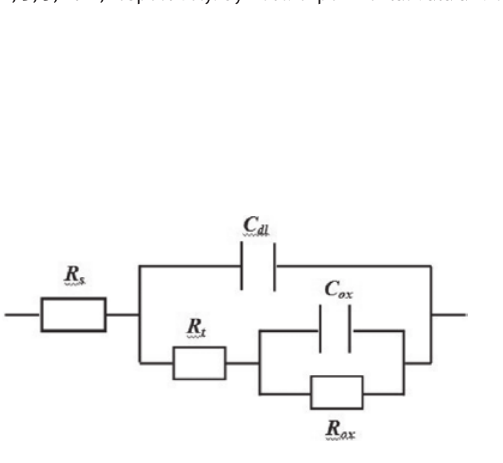
Fig. 3: Nyquist and Bode plots for the corrosion of porous Cu-35mass%Ni-10mass%Cr in molten (0.62Li,0.38K) 2 CO 3 at 650 °C in air for 1, 3, 5, 10 h, respectively. Symbol: experimental data and line: fitted data